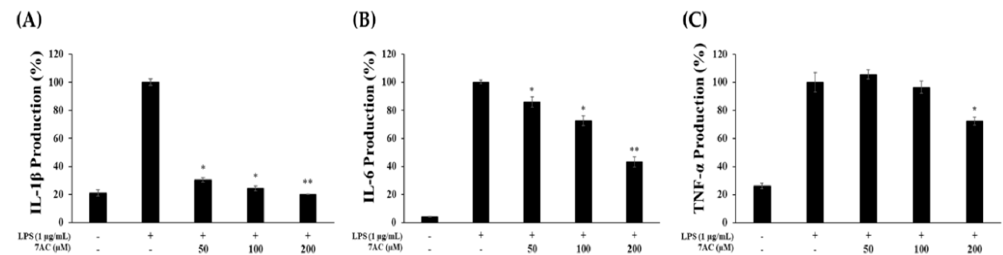
Figure 3. Effect of 7AC on ( A ) TNF- α , ( B ) IL-1 β and ( C ) IL-6 production in LPS -stimulated RAW 264.7 cells. Cells were stimulated with 1 μ g/mL of LPS only or with LPS along with varying concentrations (50, 100 and 200 µ M) of 7AC for 24 h. Their production was determined by ELISA. The data represent the mean ± SD of triplicate experiments. * p < 0.05, ** p < 0.01 versus LPS